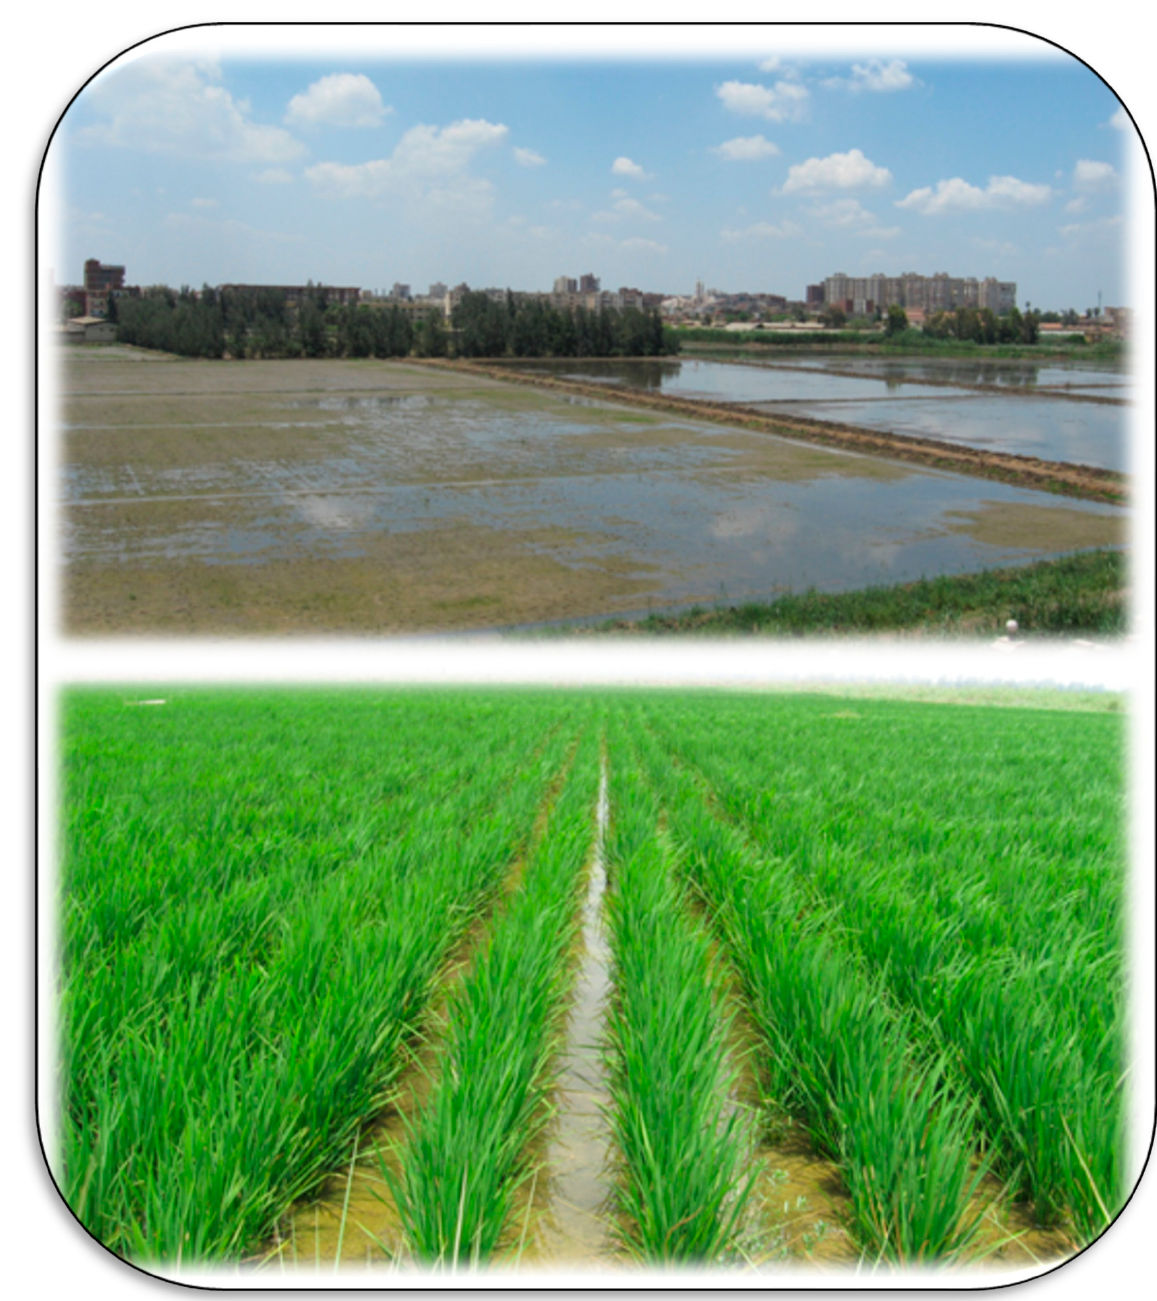
Figure 10. Cultivation of paddy rice is very important in managing salt-affected soils in the Kafr El-Sheikh region (Egypt), which depends on the flooding irrigation to overcome soil salinity in this area. Photos by El-Ramady. Table 1. Some published studies on managing salt-affected soils using different nanomaterials and biofertilizers.